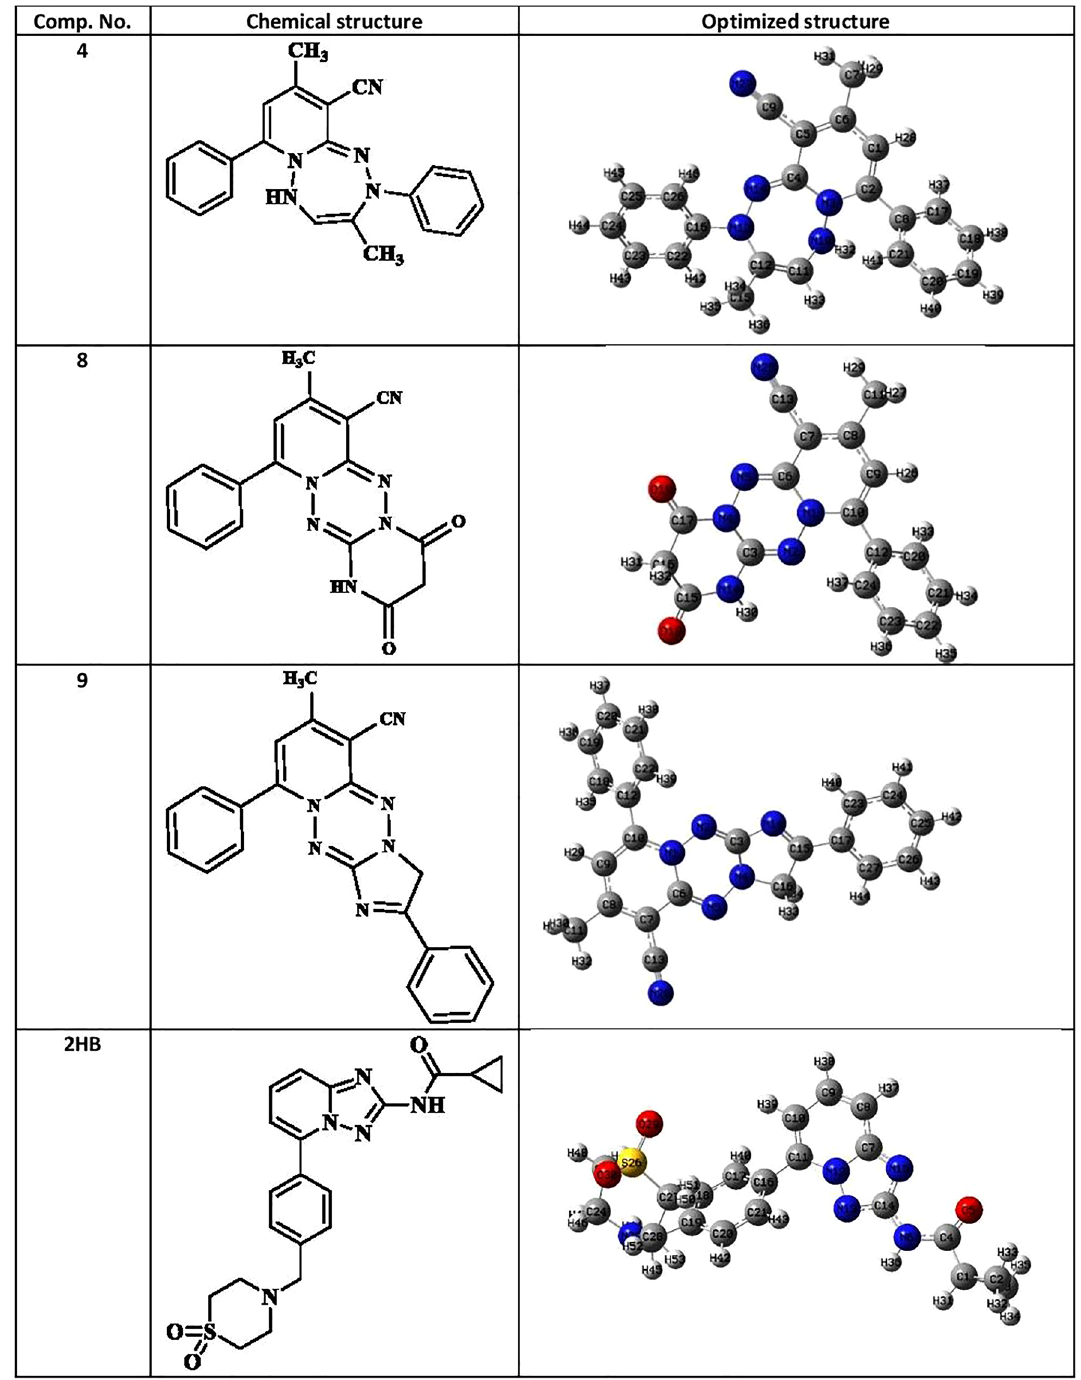
Figure 11. Chemical and optimized structure of compounds ( 4 , 8 , 9 ) and 2HB . Optimized with DFT-B3LYP/6-